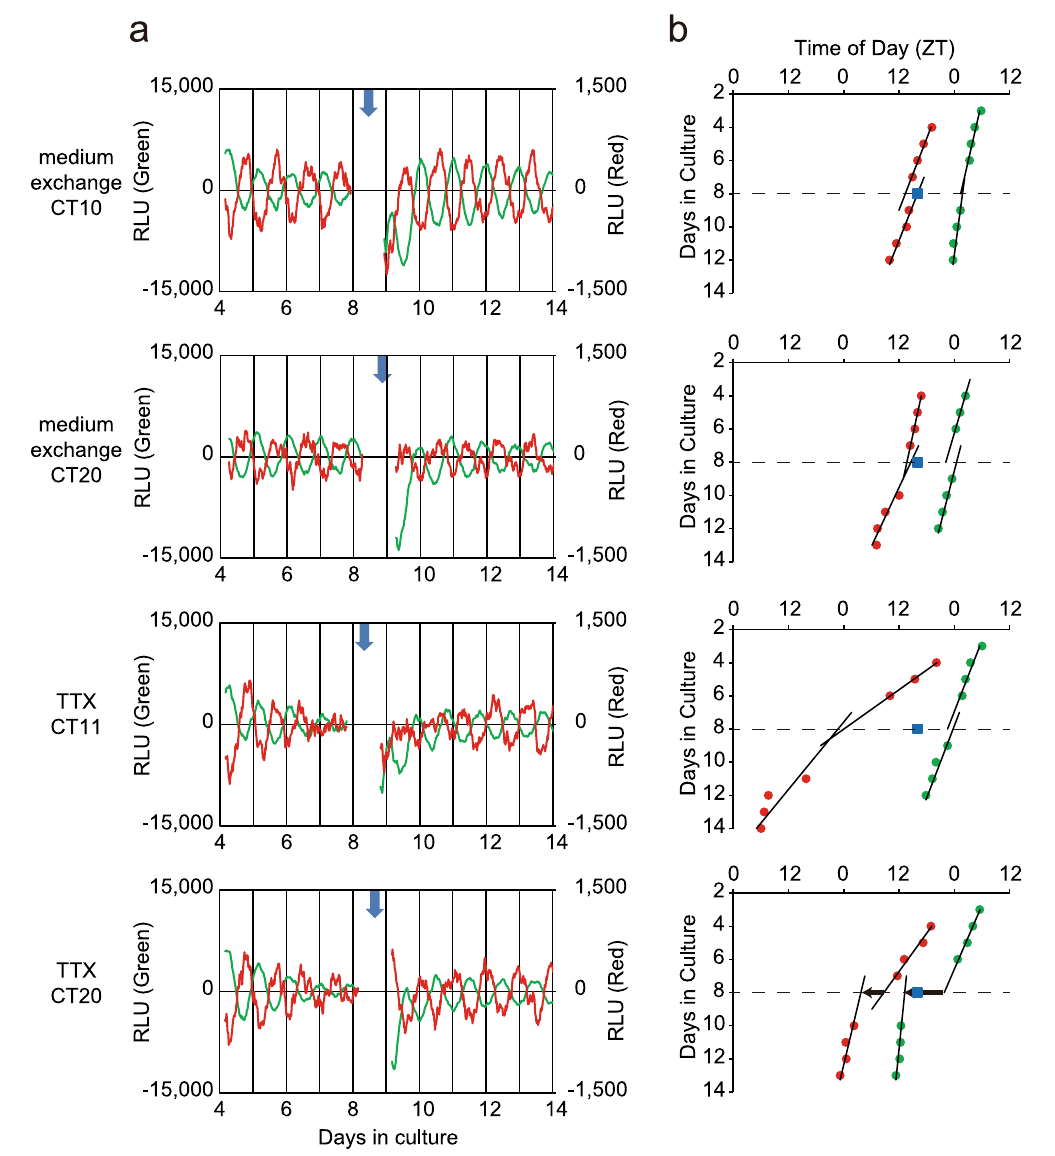
Figure 5. Phase shifts of circadian Bmal1 and Per2 rhythm in the adult SCN slices in response to medium exchange and effects of TTX pretreatment ( a ) Representative records of phase shifts in response to medium exchange in the adult SCN pretreated with distilled water (upper, upper most) and with TTX (lower, lower most). See also the legend for Fig. 3a. ( b ) Successive circadian peaks with regression lines fitted to them before and after medium exchange in the same SCN as used for ( a ). See also the legend for Fig.